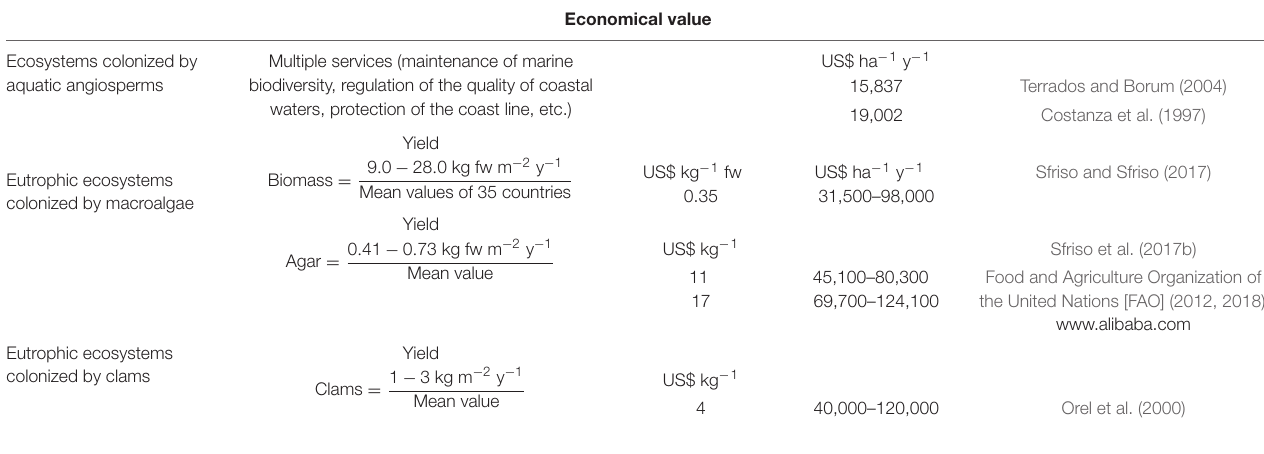
TABLE 3 | Economical value of ecosystems colonized by aquatic angiosperms, macroalgae and clams. Economical value Ecosystems colonized by Multiple services (maintenance of marine aquatic angiosperms biodiversity, regulation of the quality of